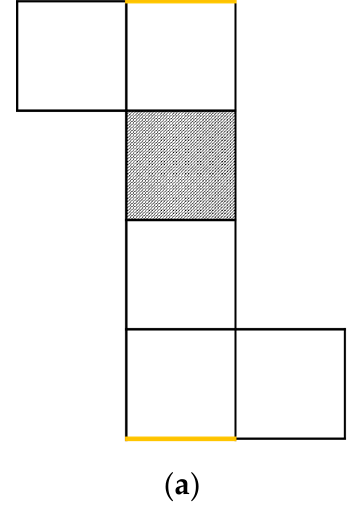
Figure 1. Depiction of the stimuli: ( a ) The stimulus requires three imaginative folds without directional changes. The highlighted (yellow) lines overlap in the imagined cube. ( b ) The stimulus requires five imaginative folds with four directional changes. The highlighted lines do not overlap in the imagined cube.